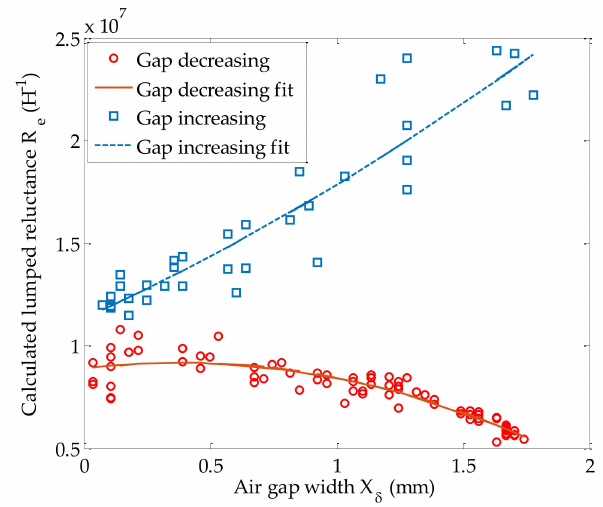
Figure 9. Relationship between x δ and R e when the air gap increases or